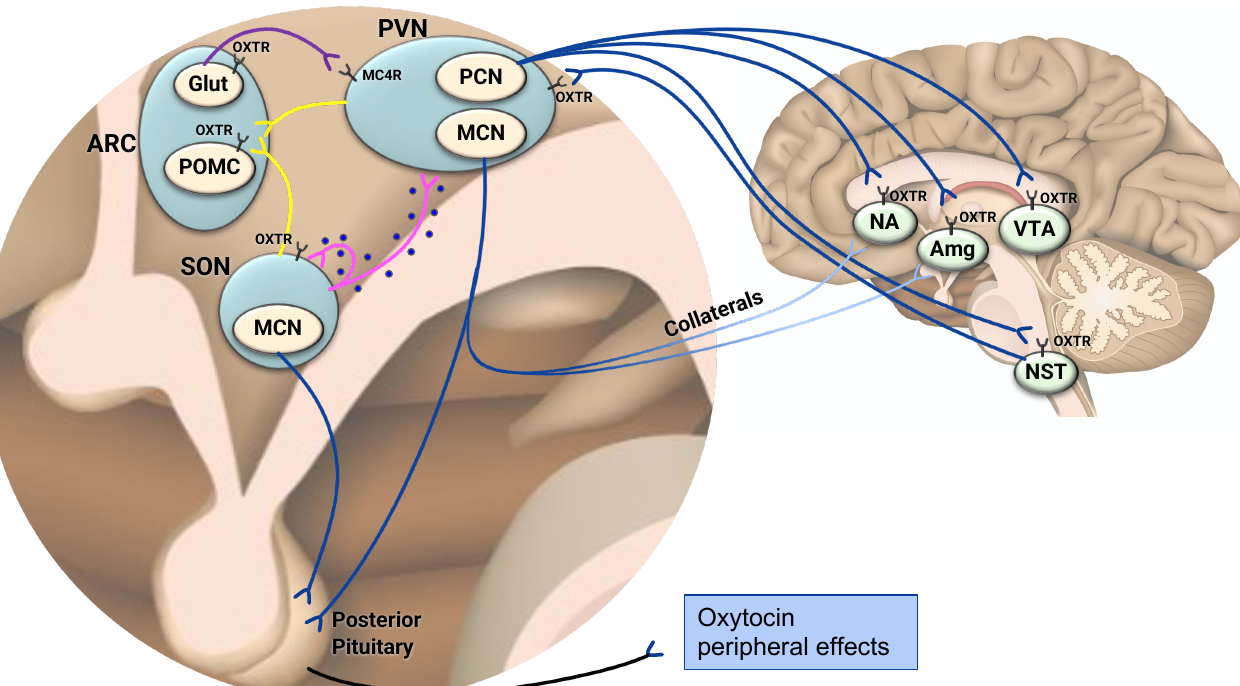
Figure 1. The participation of oxytocin in appetite regulation and metabolism. Oxytocin is produced in parvocellular neurons located in the paraventricular nucleus (PVN) and in magnocellular neurons located in the PVN and supraoptic nucleus (SON). Shown in the figure are some of the oxytocinergic pathways affecting appetite and metabolism. Glutamate releasing ARC neurons that express the OXTR and project to melanocortin 4 receptor (MC4R) expressing neurons in the PVN (purple lines) induce rapid satiation when chemo- or optogenetically stimulated. Oxytocinergic neurons originating from the PVN and SON and reaching POMC OXTR expressing ARC neurons (yellow lines) also induce satiation. Somato- dendritic secretion of oxytocin from magnocellular cells (pink arrows) results in autocrine and paracrine local effects. Axonal oxytocinergic projections from the PVN (blue lines) reach multiple brain regions involved in shaping eating behavior (shown in the figure is the ventral tegmental area (VTA), nucleus accumbens (NA), amygdala (Amg), and the nucleus of solitary tract (NST)). Oxytocin synthesized in magnocellular cells is carried by axonal transport to the posterior pituitary (blue lines), where it is stored until release into the systemic circulation. Peripheral circulating oxytocin affects multiple organs to exert metabolic effects inducing lipolysis, increased fatty acid beta oxidation, brown adipose tissue thermogenesis, bone mineralization, and skeletal muscle